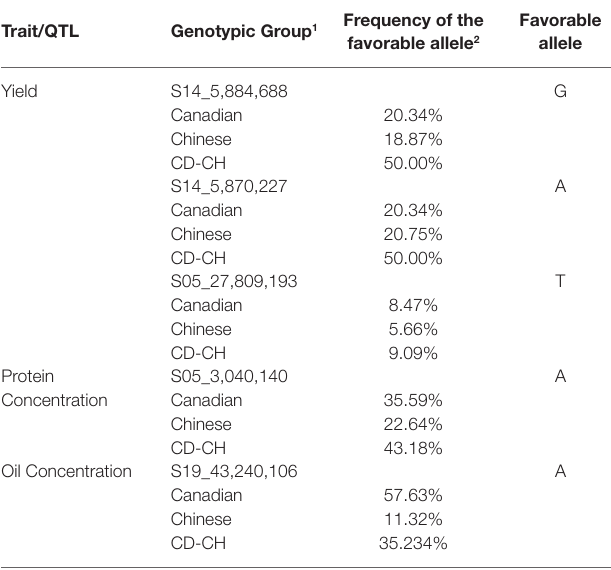
TABLE 3 | Distribution of alleles in Canadian, Chinese, and CD-CH germplasm for soybean seed yield, seed oil, and protein concentration QTL. Trait/QTL Genotypic Group